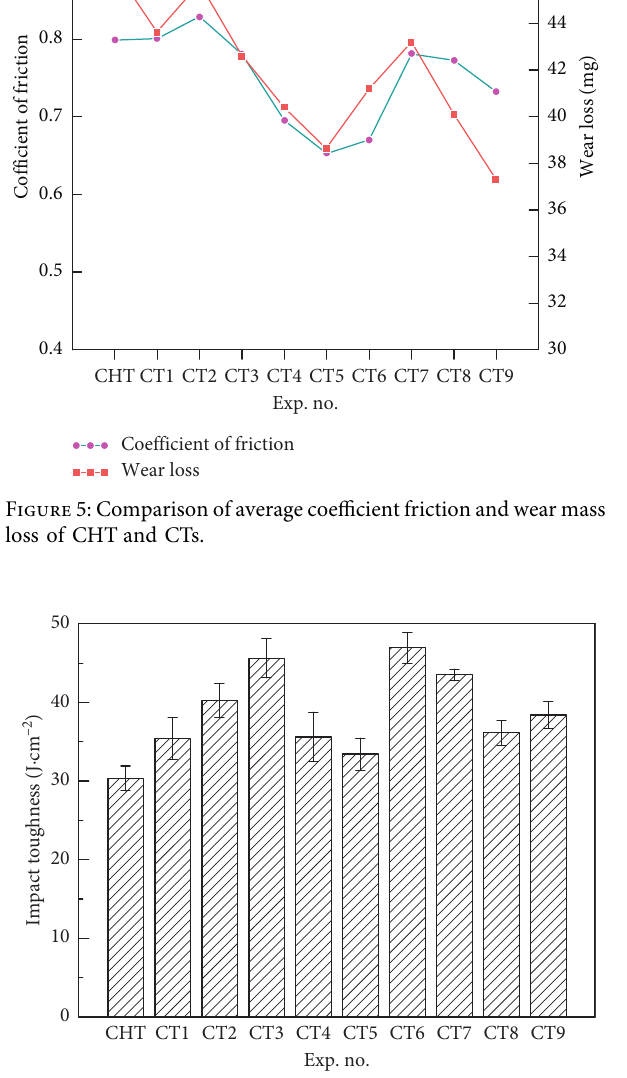
Figure 6: Impact toughness with errors of CHTand CTspecimens. Table 6: Range analysis results of impact toughness. Factor ( j ) A B